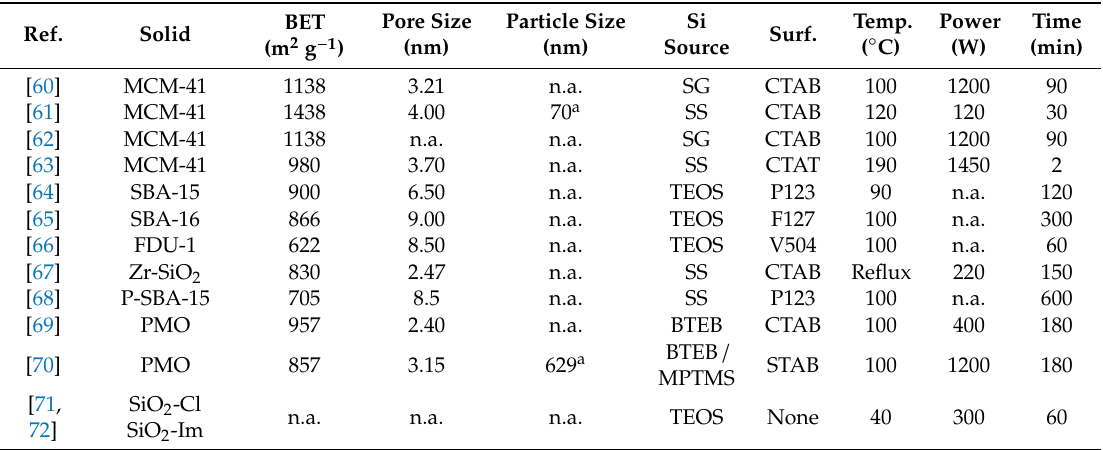
Table 3. Synthesis parameters and characterization of the mesoporous solids prepared under microwave irradiation